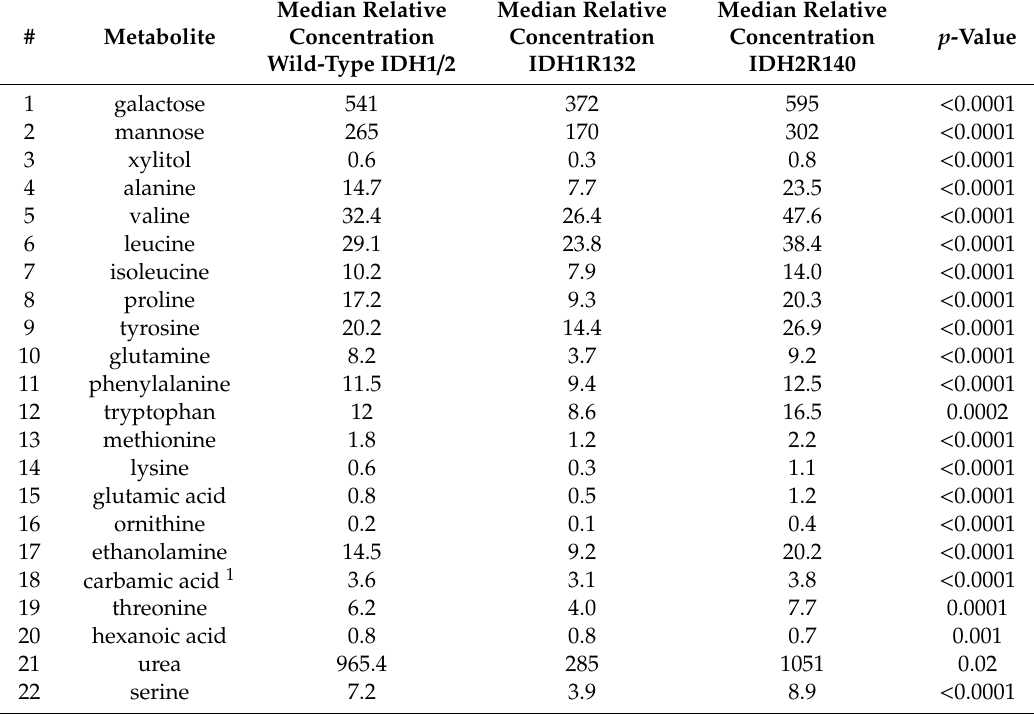
Table 1. Plasma metabolite relative concentration (metabolite peak area / internal standard peak area) di ff erences between wild-type AML patients and those with IDH1R132 and IDH2R140 mutations. The three groups were compared using nonparametric ANOVA (Kruskal–Wallis